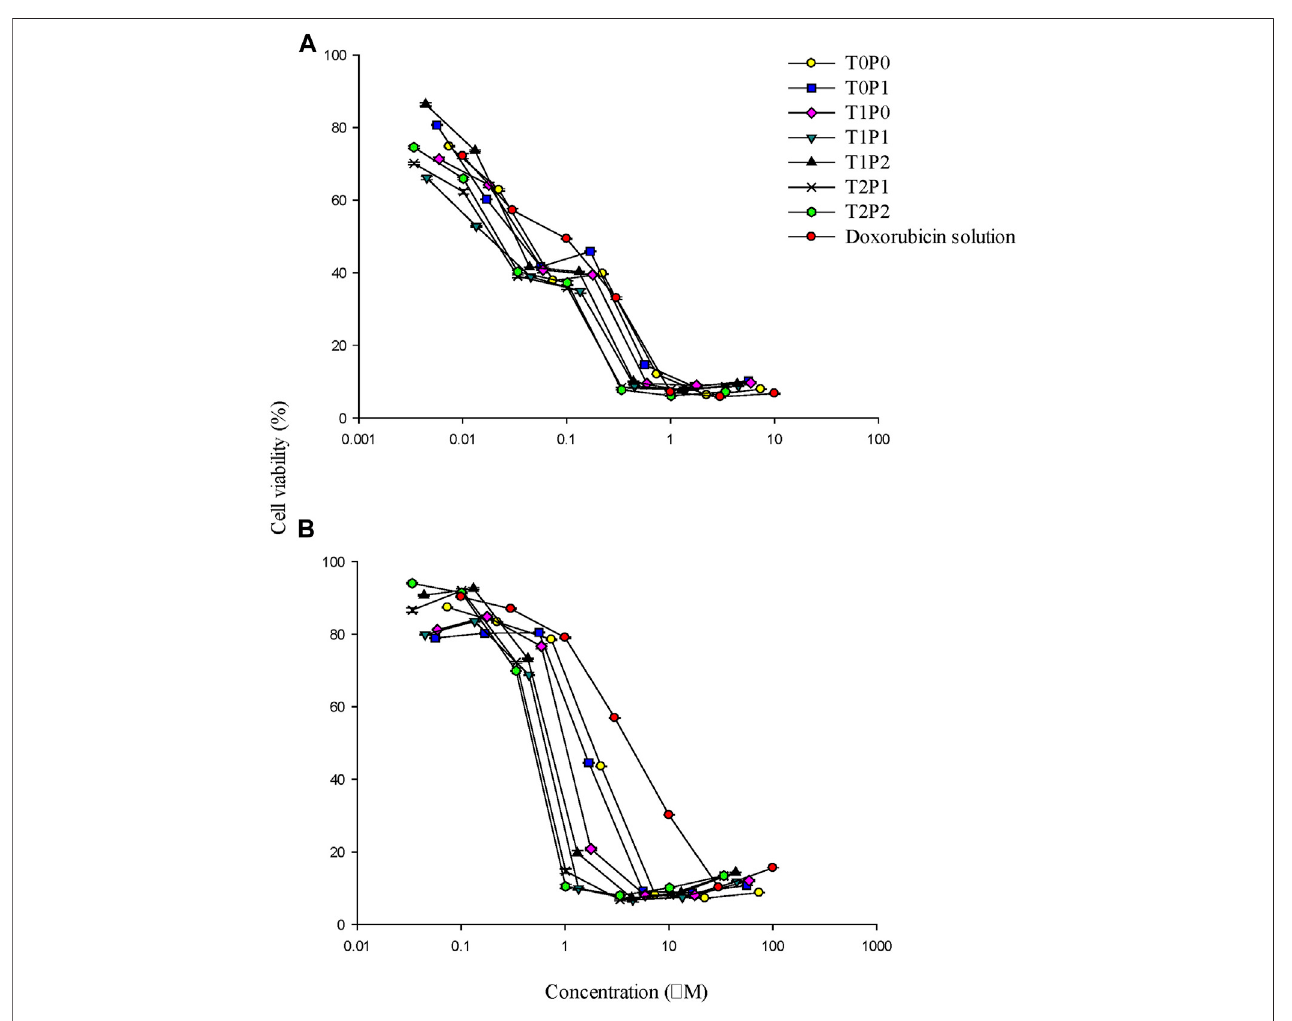
FIGURE 7 | The cytotoxicity pro fi les of doxorubicin-loaded PBCA-NPs formulations from MTT assays performed on (A) SW620 and (B) AD300 cell lines (data present mean ± SD, n (cid:1) 3).